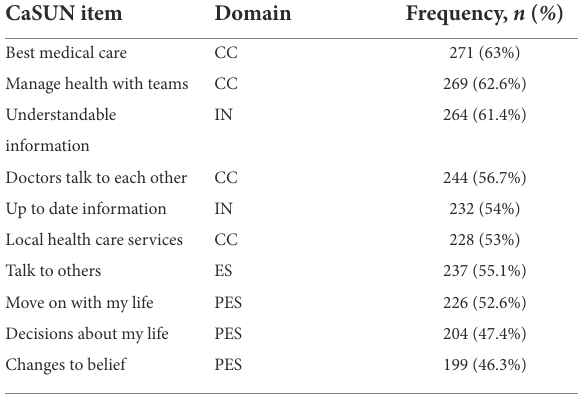
TABLE 3 Breast cancer survivors’ 10 most common met